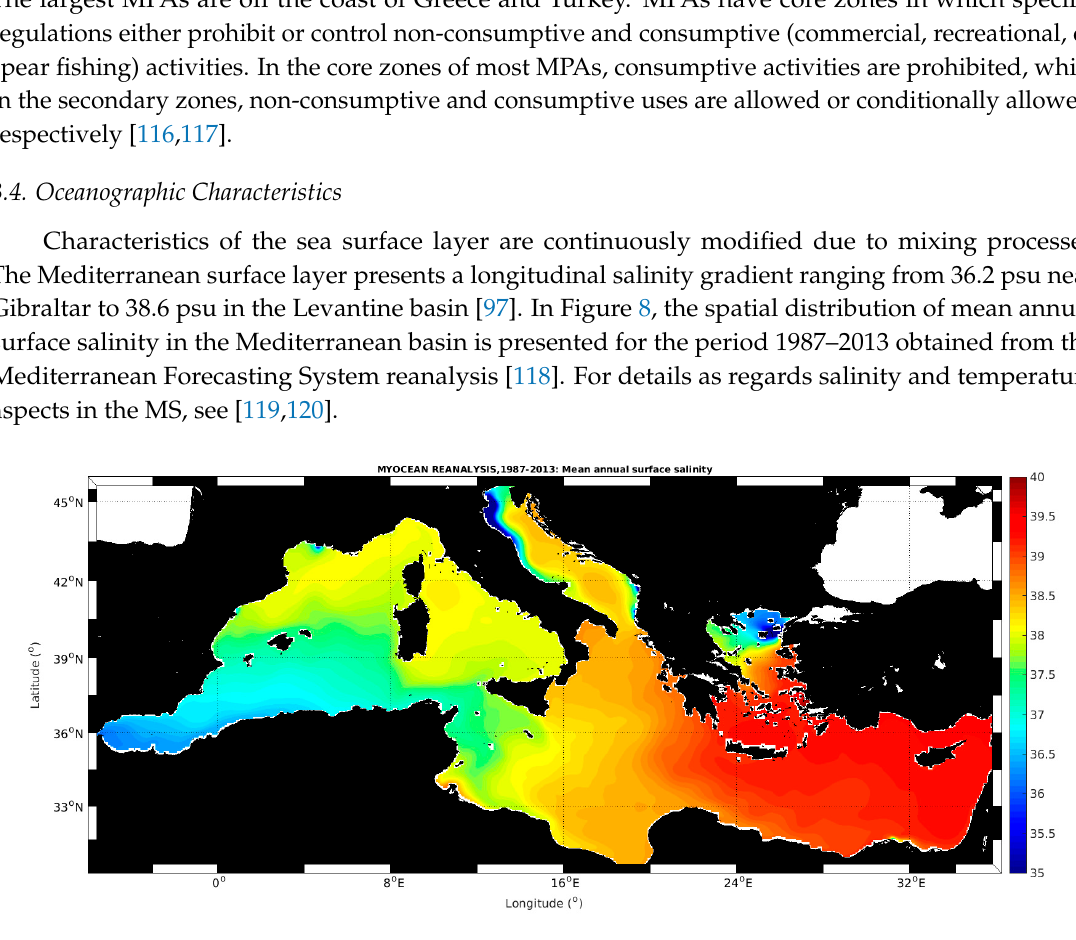
Figure 8. Mean annual surface salinity in the Mediterranean Sea. Data obtained from Mediterranean Forecasting System reanalysis [118], and analyzed by HCMR.